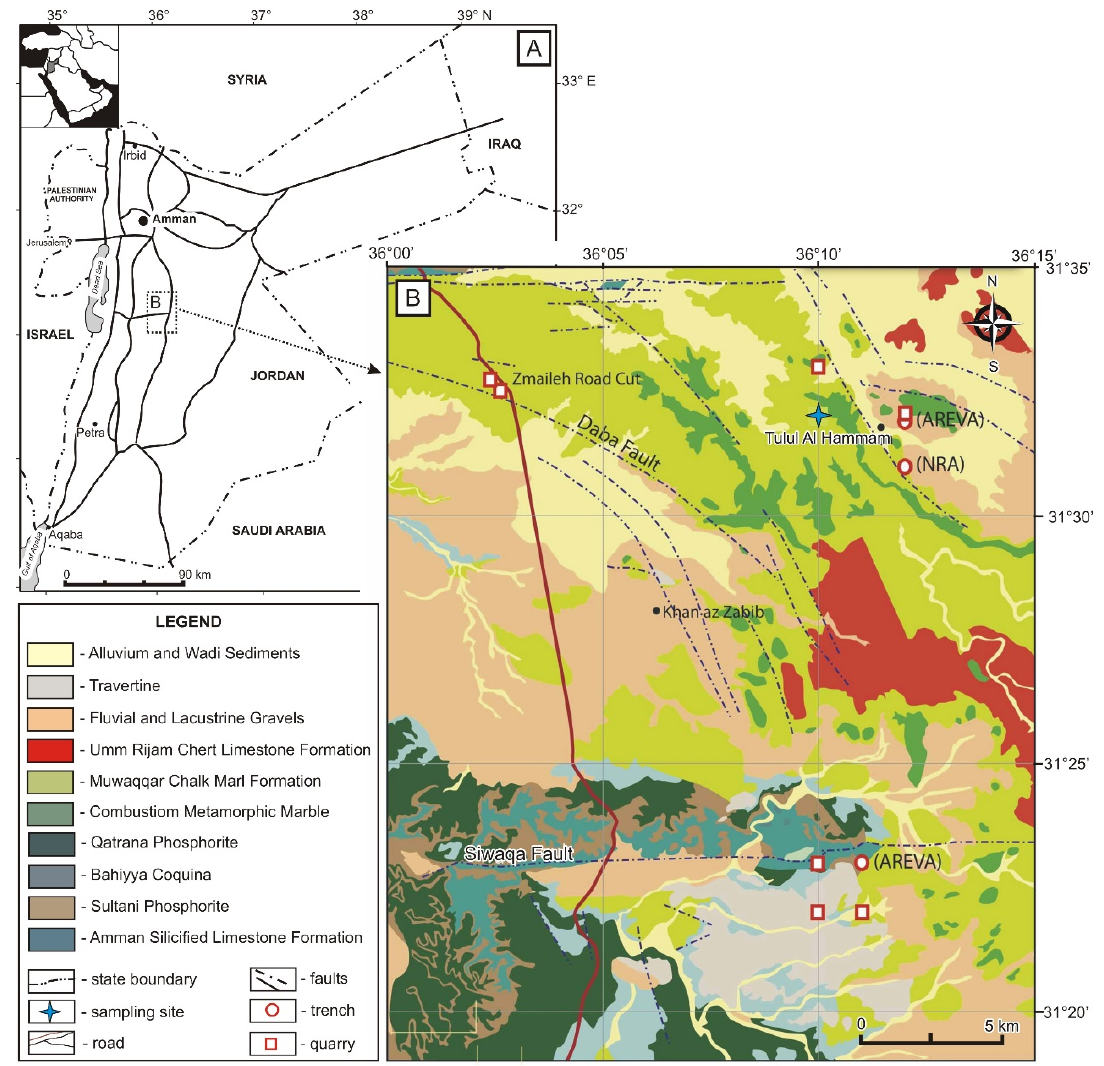
Figure 1. ( A ) Location map of the Daba-Siwaqa complex, modified after [14]. ( B ) Detailed geological map of the Daba-Siwaqa complex showing the location of the Tulul Al Hammam area, modified after [18].